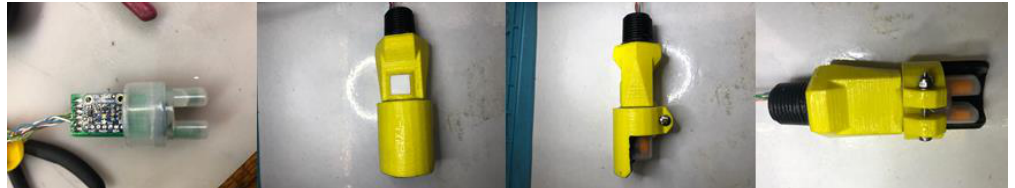
Figure 9. Encasing and waterproofing the turbidity sensor.